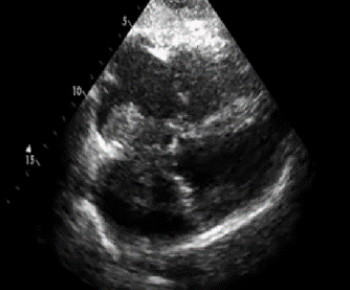
Figure 4. Input image.